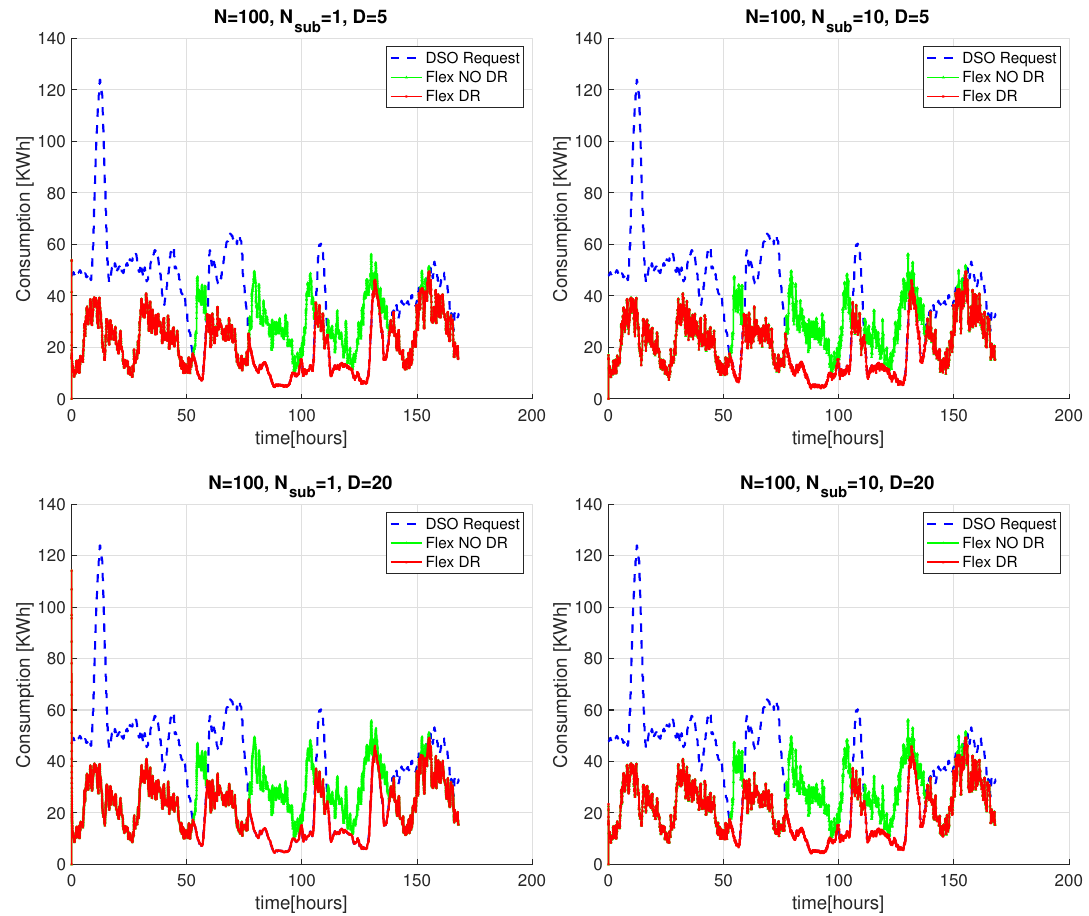
Figure 8. DSO adaptation of PP-Overgrid algorithm with N = 100 nodes, subnodes n = { 1,10 } and graph degree D = { 5,20 }